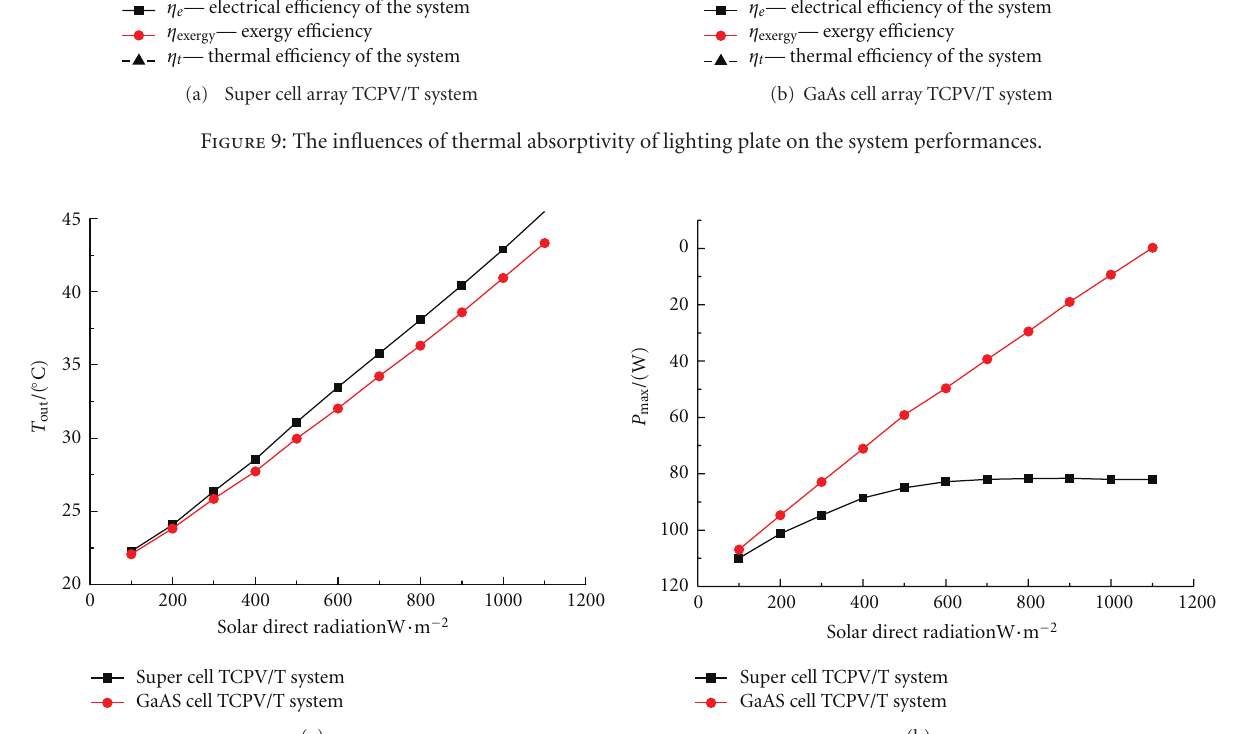
Figure 10: The influences of solar direct radiation on the system